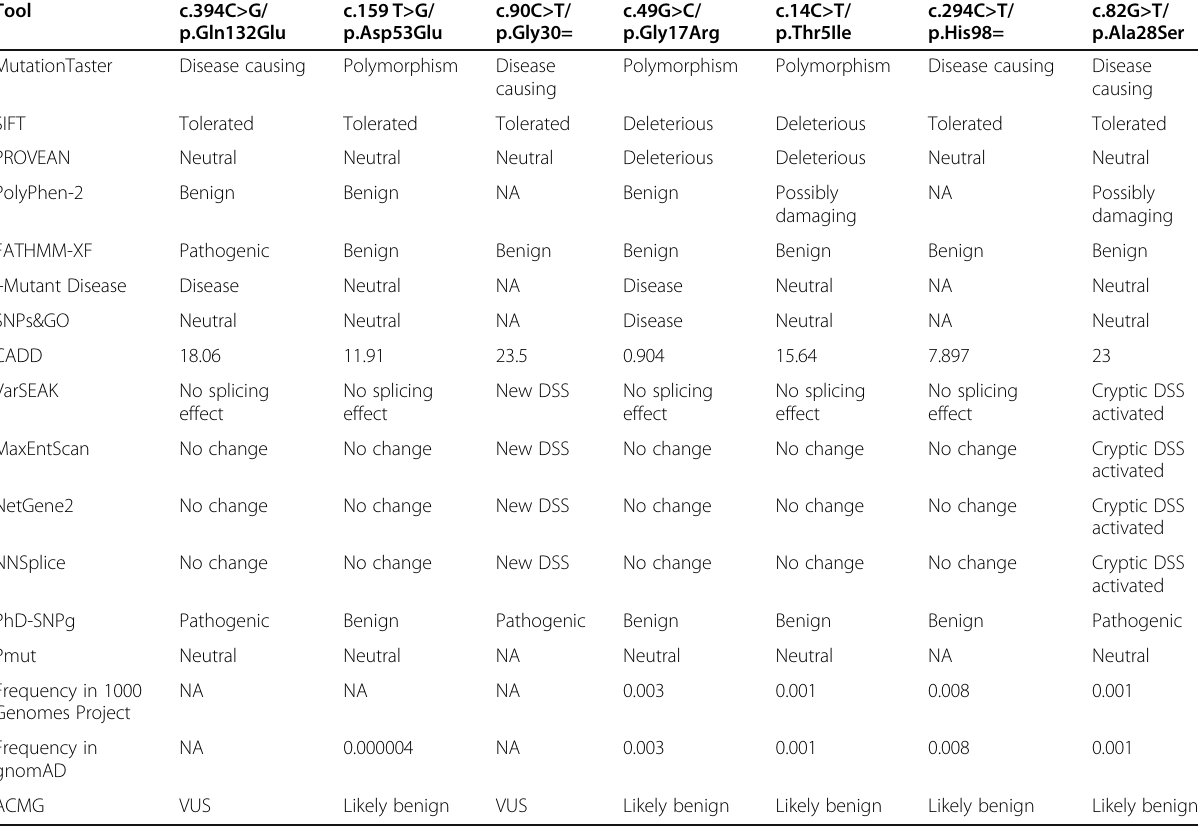
Table 3 In silico prediction of exonic variants observed in the HBD gene in the Iranian population, based on the Iranome project